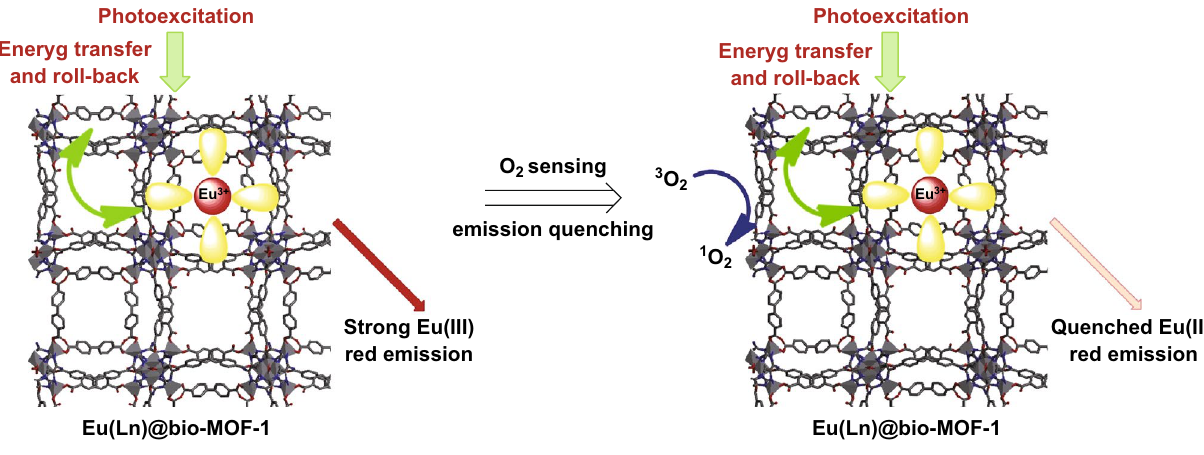
Fig. 15 Sensing mechanism of Eu(Ln)@bio-MOF-1 composite samples toward O 2 . Reproduced with permission from Ref. [52]. Copyright 2019,